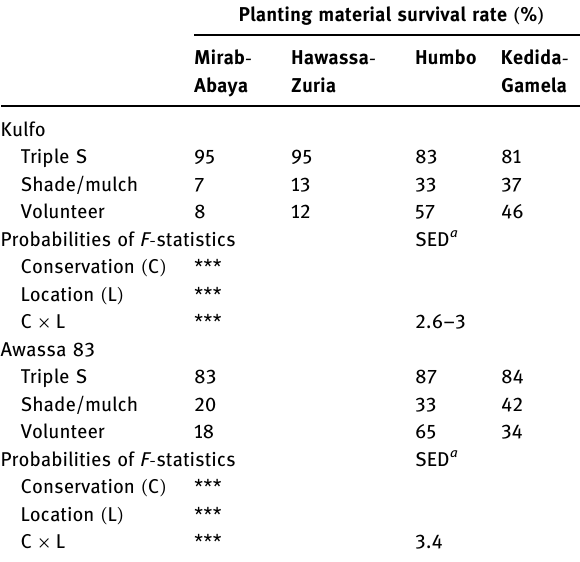
Table 1: E ff ects of conservation methods and locations on plants/ roots survived ( % ) over the dry period in southern Ethiopia ( 2015 ) Planting material survival rate ( %